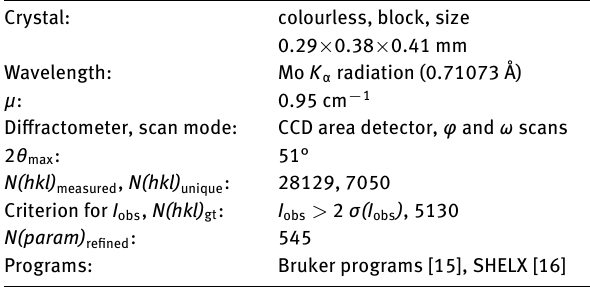
Table 1: Data collection and handling.